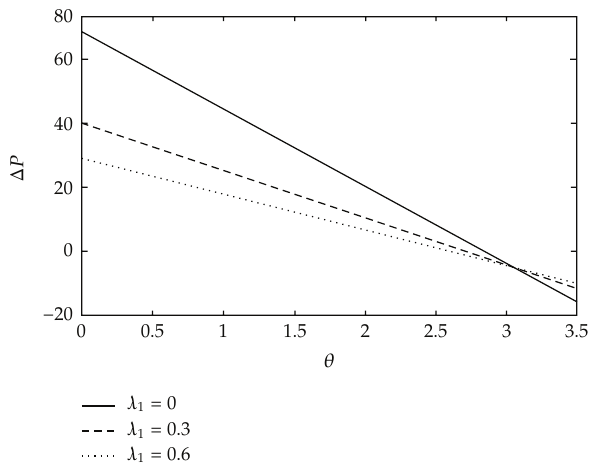
Figure 4: The pressure rise verses flow rate when α (cid:9) 0 . 01 , a (cid:9) 0 . 2 , b (cid:9) 0 . 6 , d (cid:9) 0 . 8 , ε (cid:9) 0 . 3 , Da (cid:9) 0 . 8, and φ (cid:9) π/